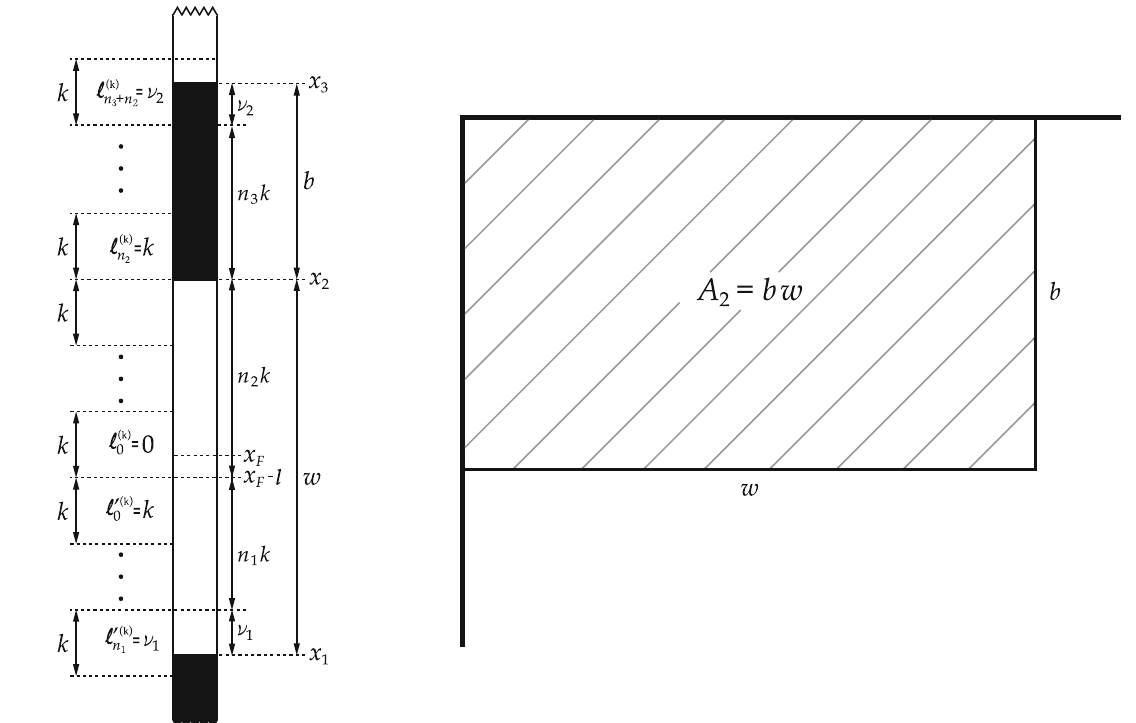
Fig. 2 The droplet and the Young diagram representation of LLM geometries with single finite size black/white